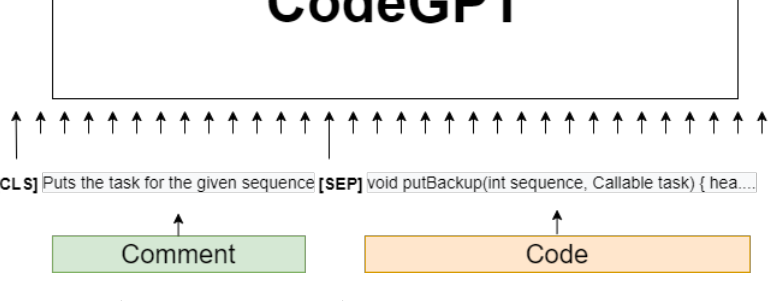
Figure 4. CodeGPT pre-training architecture.